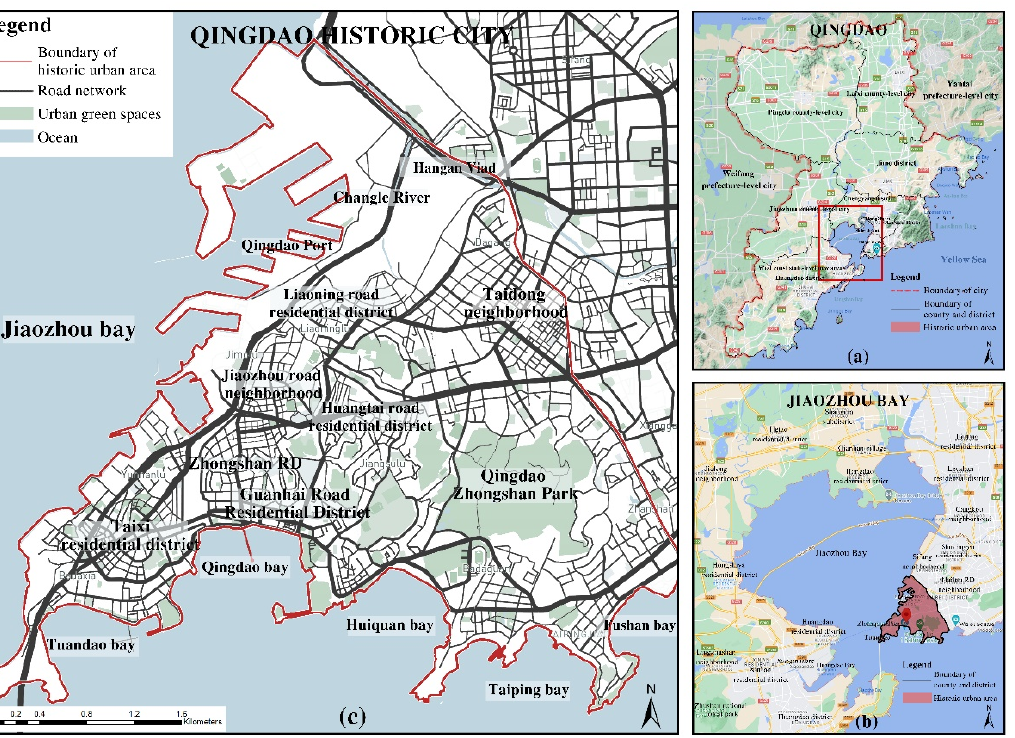
Figure 1. Study area. ( a ) Qingdao city area. ( b ) Location of Qingdao Historic City in Jiaozhou Bay. ( c ) Scope of Qingdao historic city.